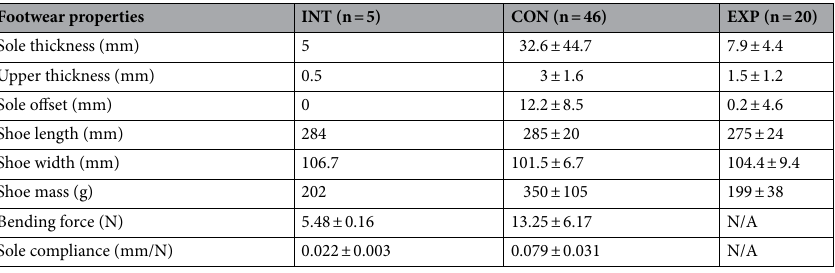
Table 3. Spatial and material properties of the footwear used in the intervention study (INT), the ‘conventional’ footwear (CON) worn by the intervention study participants before they took part in the study, and the minimal footwear worn by the experienced participants on the day of testing (EXP).